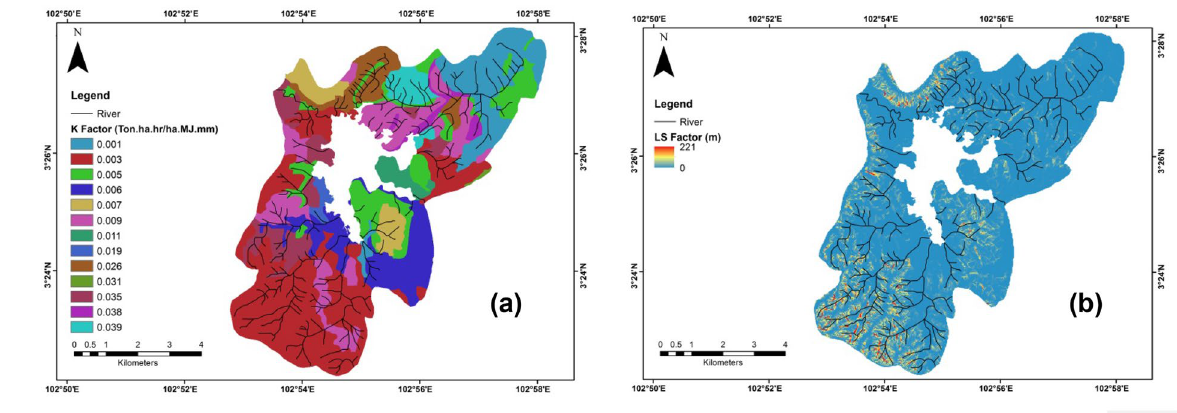
Fig. 3 Spatial variation of ( a ) K factor and ( b ) LS factor in Chini lake basin